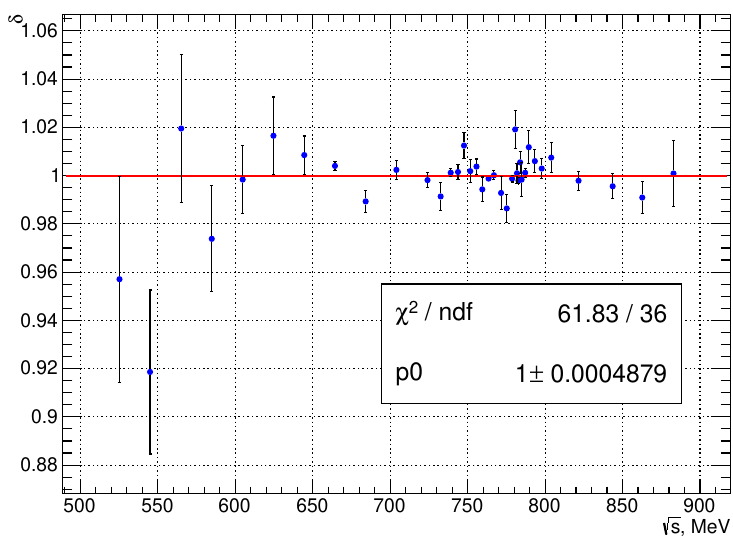
p s . Line depicts an average